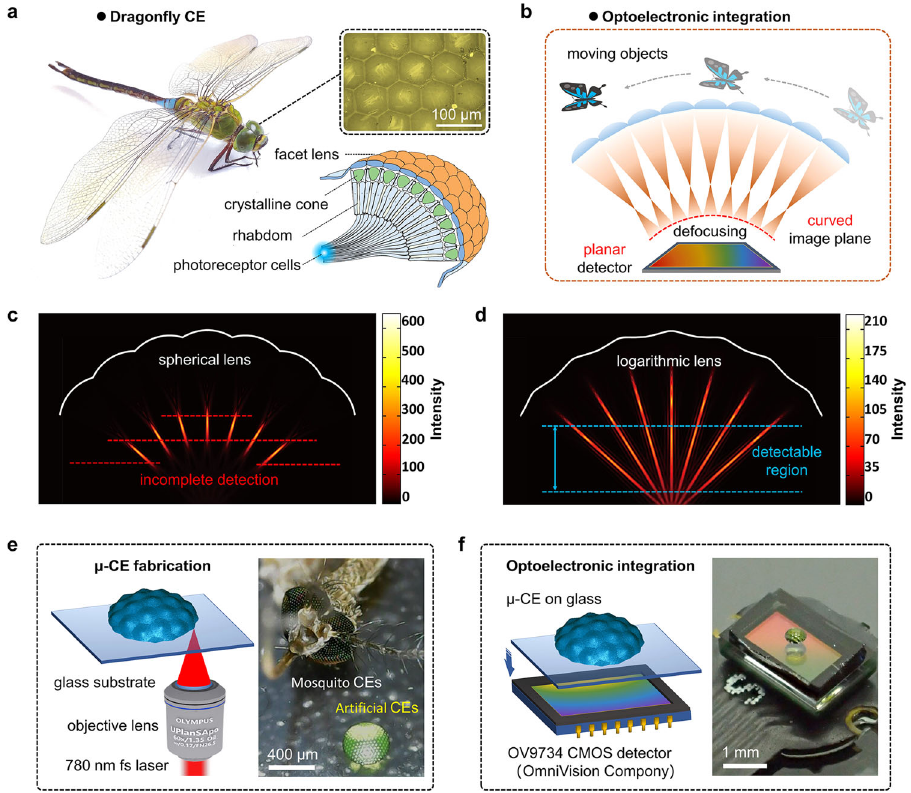
Fig.1|DesignandfabricationoftheoptoelectronicCEcamera.a Photographof a dragon fl y; the insets are the microscopic image of its CE and the schematic diagram of the organism underneath. b Schematic illustration of the defocusing issue in optoelectronic integration; there isa mismatch between the curved image surfaceandtheplanarimagesensor. c , d Simulated light fi eldof CEswithspherical ommatidia( c )andlogarithmicommatidia( d